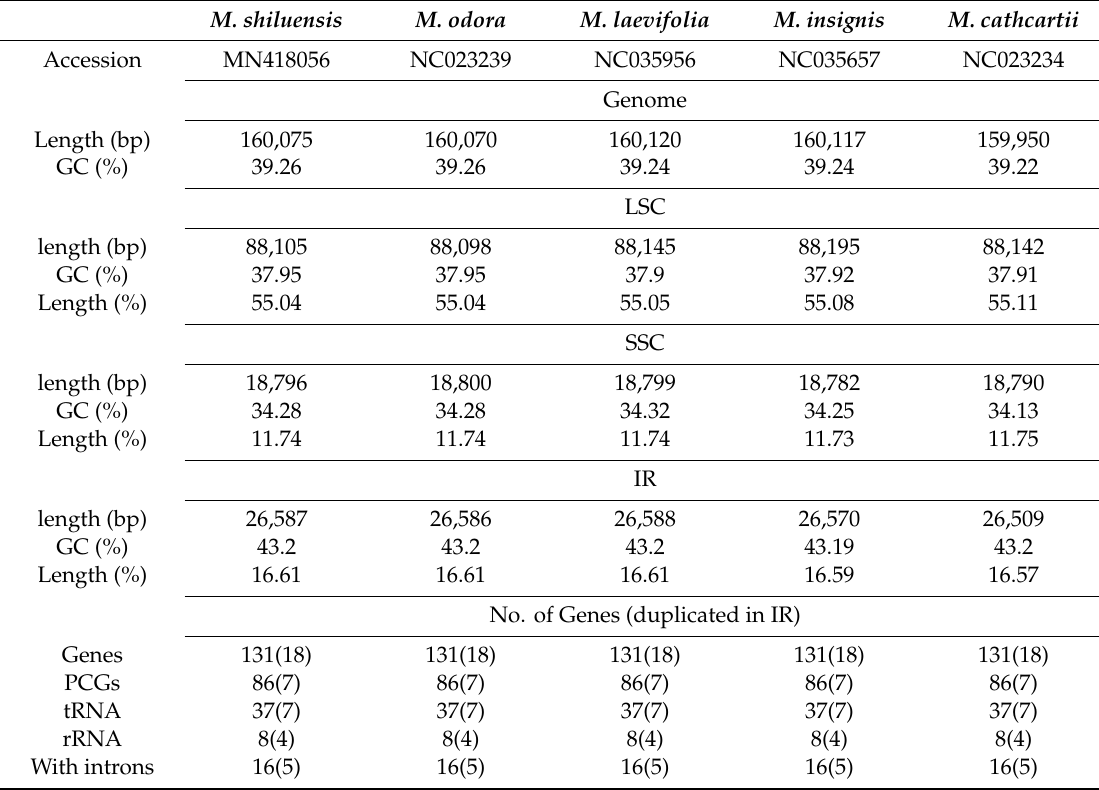
Table 1. Summary of the chloroplast genomes of Michelia shiluensis and four closely related species ( Michelia odora , Magnolia laevifolia , Magnolia insignis , and Magnolia cathcartii